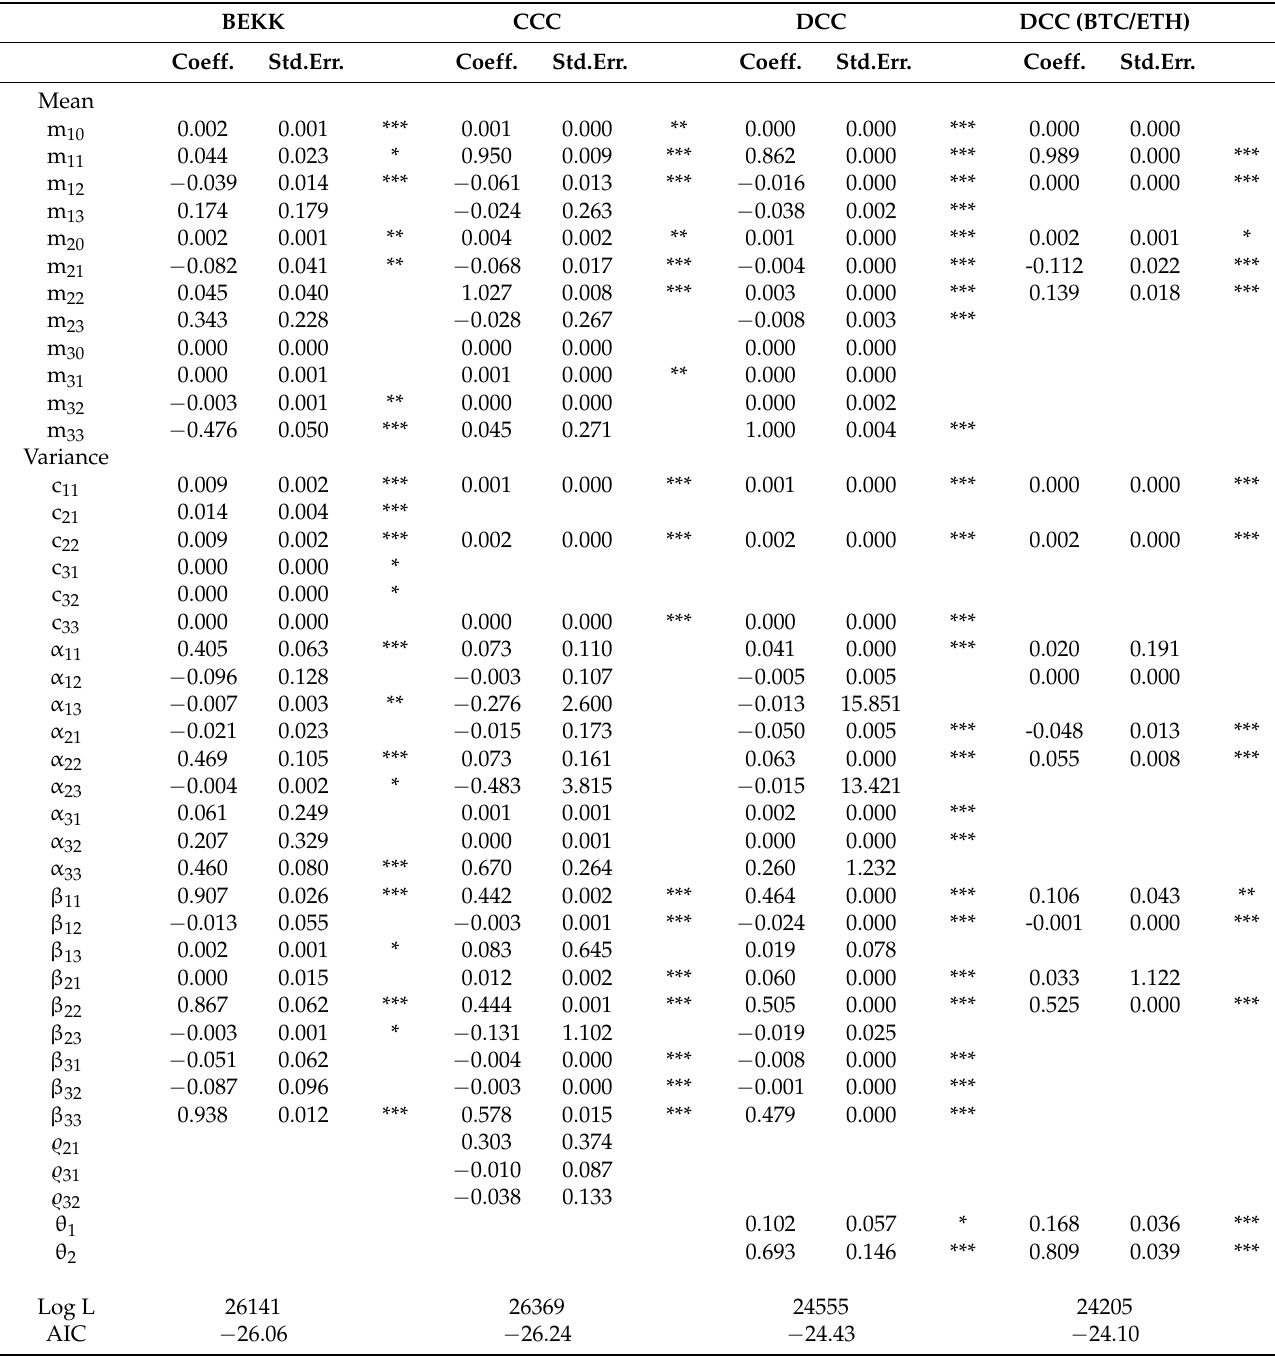
Table 4. MGARCH parameter